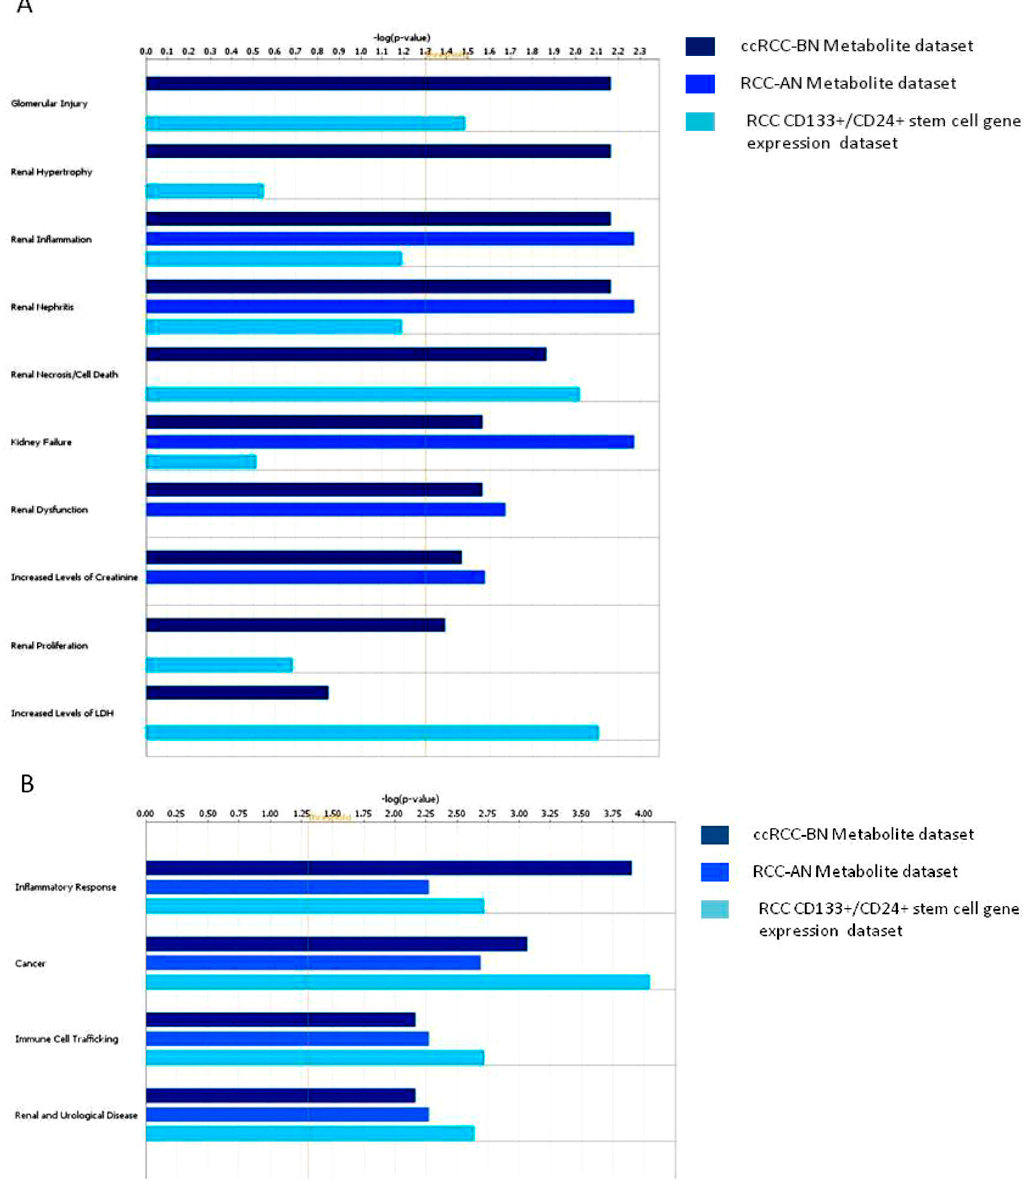
Figure 6. Comparative analysis of biological functions ( A ) and biological processes ( B ) generated from urinary metabolites modulated in ccRCC patients before and after nephrectomy and from gene differentially expressed in CD133+/CD24+ stem cells of ccRCC. Dark-blue bars represent ccRCC-BN urinary metabolite dataset, blue bars represent urinary metabolite dataset of ccRCC-AN and light-blue represent RCC CD133+/CD24+ stem cell gene expression dataset.